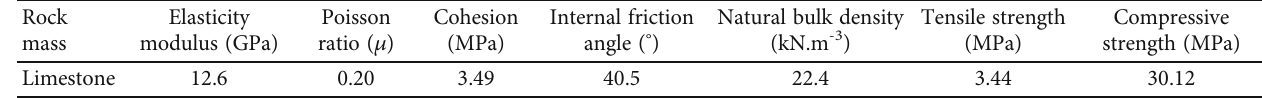
Table 1: Rock physical and mechanical